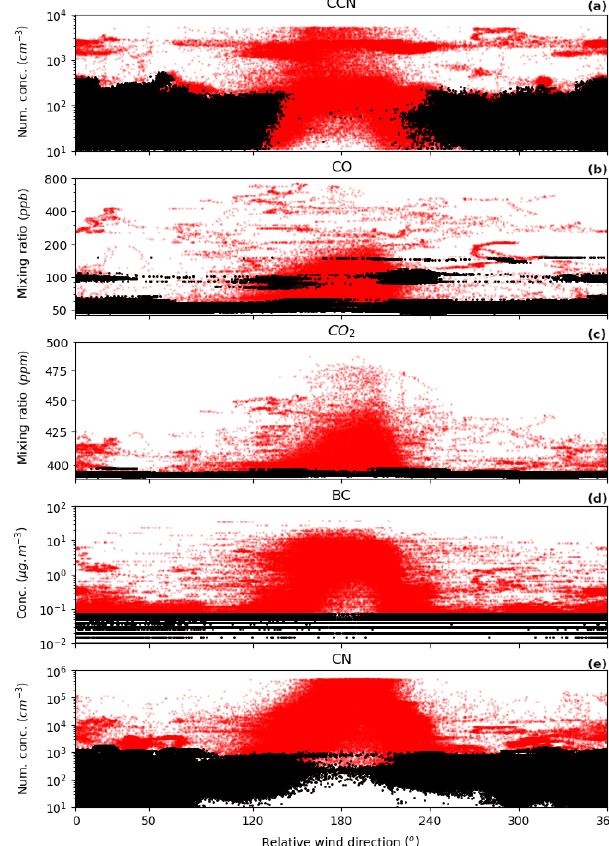
Figure A12. As in Fig. 2 but with the filtered dataset (blue) being the wind-based method. Unfiltered data are shown in red. Figure A13. As in Fig. 2 but plotted against relative wind direction. Unfiltered data are shown in red, while data with the respective ex- haust filter are shown in